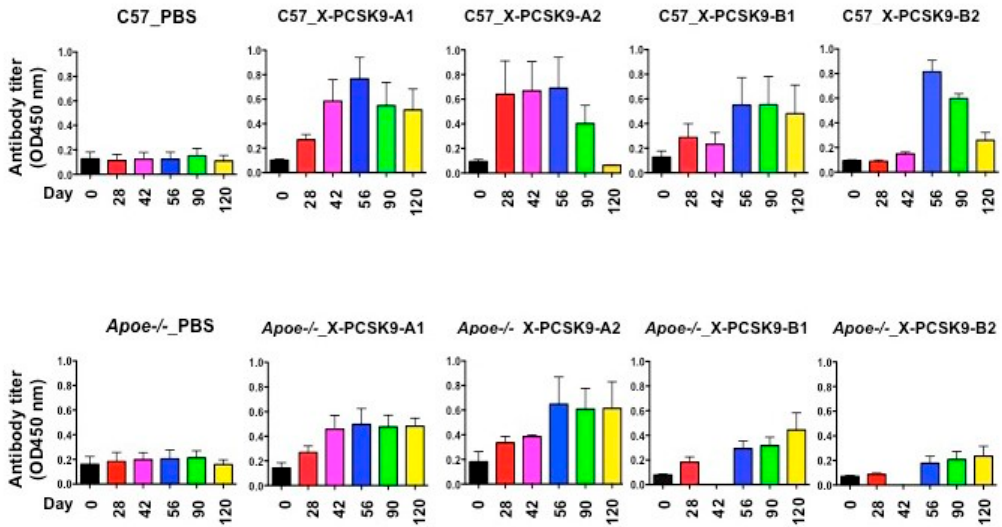
Figure 5. Immunogenicity of X-PCSK9 isomers against native PCSK9 in C57BL/6J and Apoe − / − mice. C57BL/6J ( n = 5/group) and Apoe − / − mice ( n = 5/group) were immunized with designated X-PCSK9 immunogens A1, A2, and B1, B2 as described in Figure 4. Blood from the animals was collected as described at the indicated time points (black = day-0, red = day-28, pink = day-42, blue = day-56, green = day-90 and yellow = day-120). Plasma was used to determine the antibody titer against native PCSK9 by ELISA. The results are shown as antibody titer (OD450nm) as mean ±SEM. The p-value is listed in Table 1. Table 1. Statistical analysis of immunogenicity on X-PCSK9 isomers against native PCSK9 in C57BL/6J and Apoe − / − knockout mice. Statistical analyses of all samples were performed using a linear mixed model including both fixed effects and random effects. The p -values of time effect on each treatment group are listed here. The p < 0.05 are considered significant.